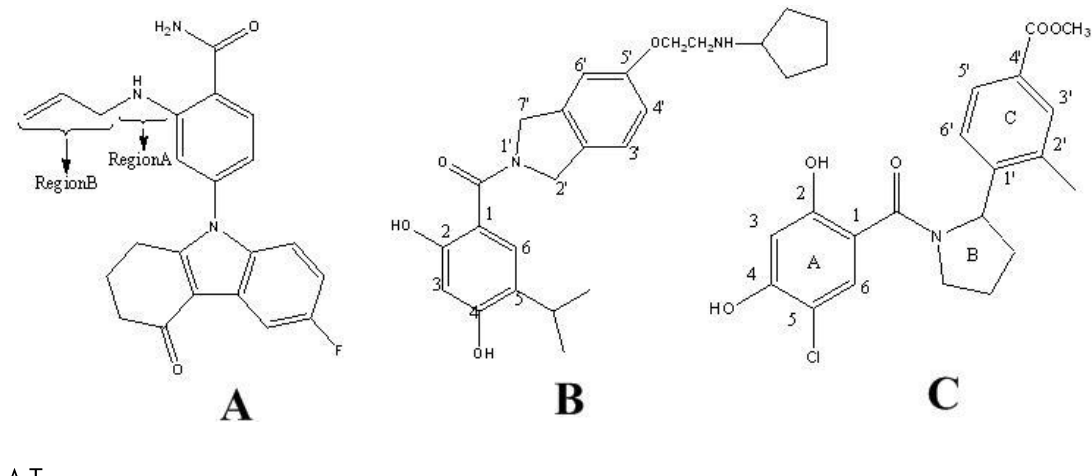
Figure 6. The most active molecule showing different regions which are used in contour analysis. ( A ) Compound 17 in the group of benzamide tetrahydro-4 H -carbazol-4-one analogs; ( B ) Compound 24 in the class of AT13387 Derivatives; ( C ) Compound 19 in the series of dihydroxylphenyl